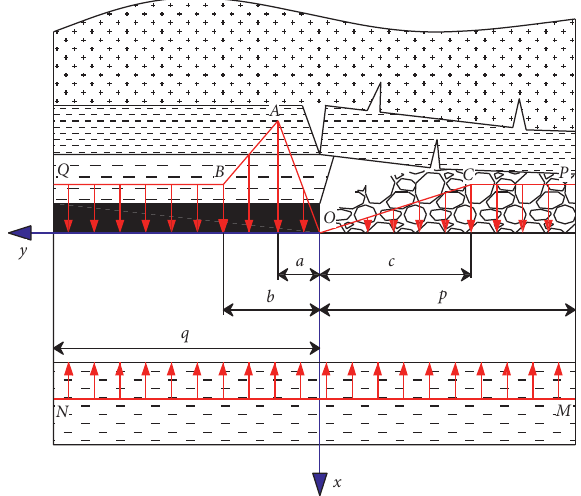
Figure 4: Mechanical model of stope floor along the